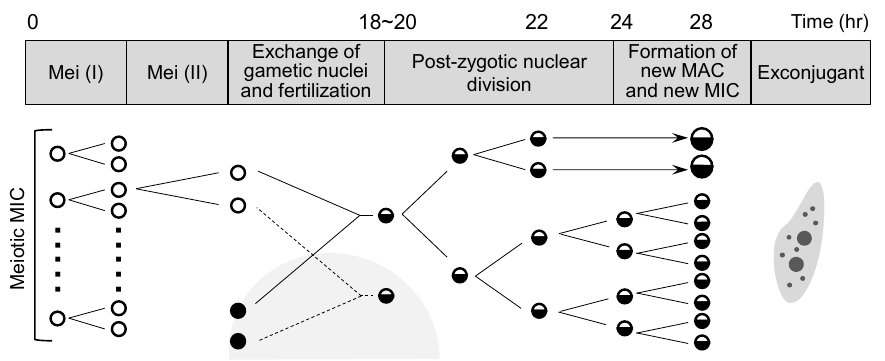
Figure 2. Nuclear changes of micronuclei during conjugation in B. japonicum (modified from [24]). Mei (I): Meiosis I, Mei (II): Meiosis II.